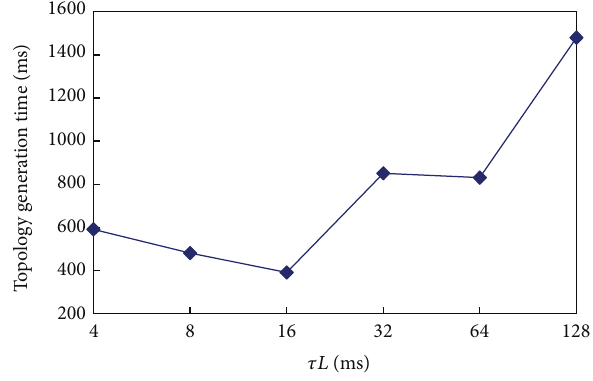
Figure 3: Time of generating the